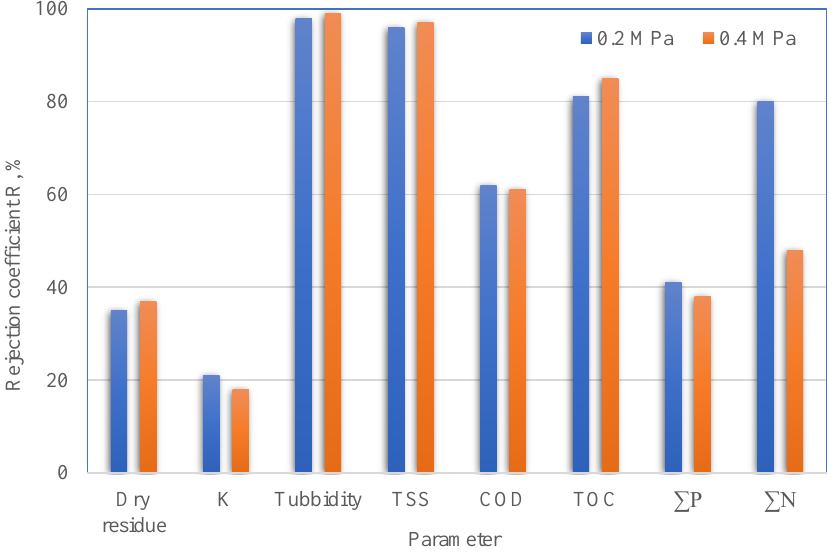
Figure 6. Rejection coefficients vs. physicochemical parameters of PPW purified under operating pressure of 0.2 and 0.4 MPa.